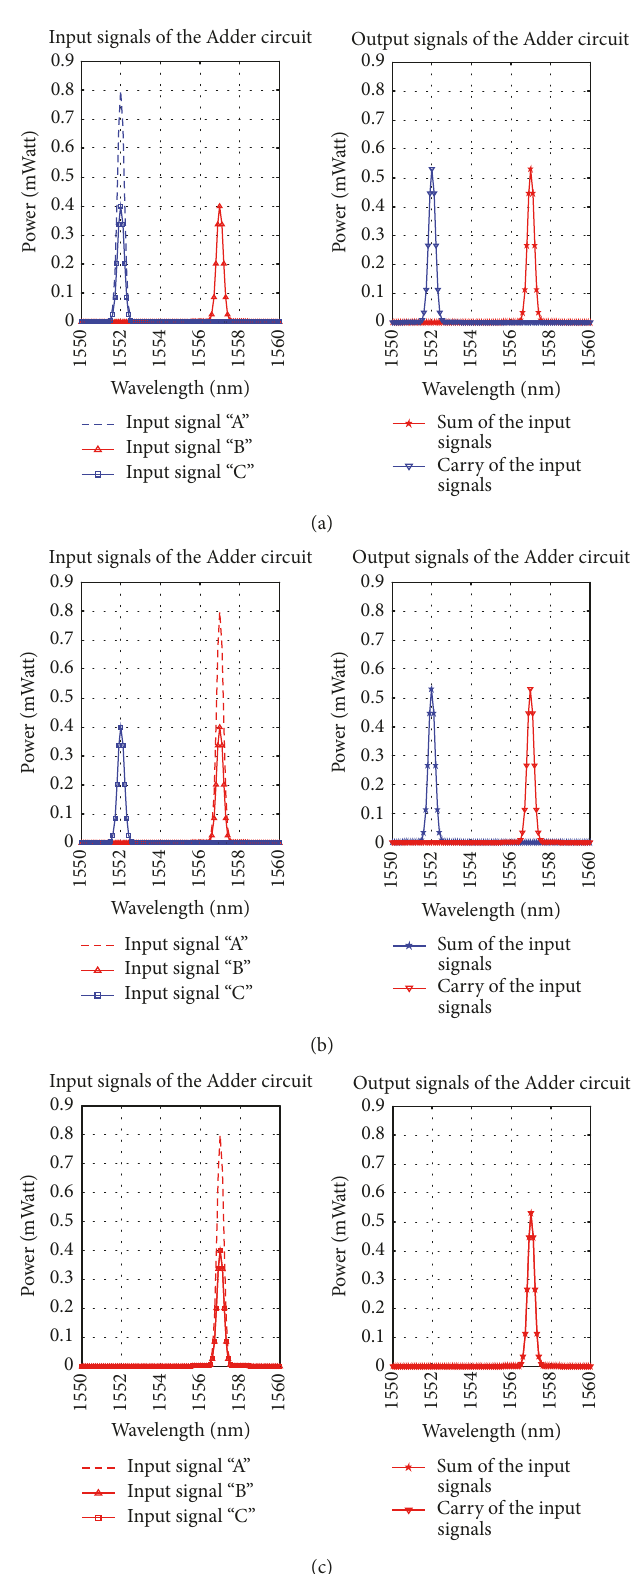
Figure 10: Simulated power spectrum of the optical full adder using reversible Peres